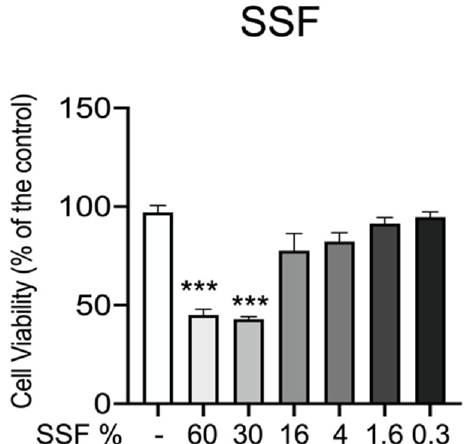
Figure 1. Role of SSF on CPEK viability. Cell viability was assessed by MTT tetrazolium dye. Concentration of 60% and 30% significantly decreased cell viability. Data representative of at least three experiments, means ± SEM *** p < 0.001 versus control.